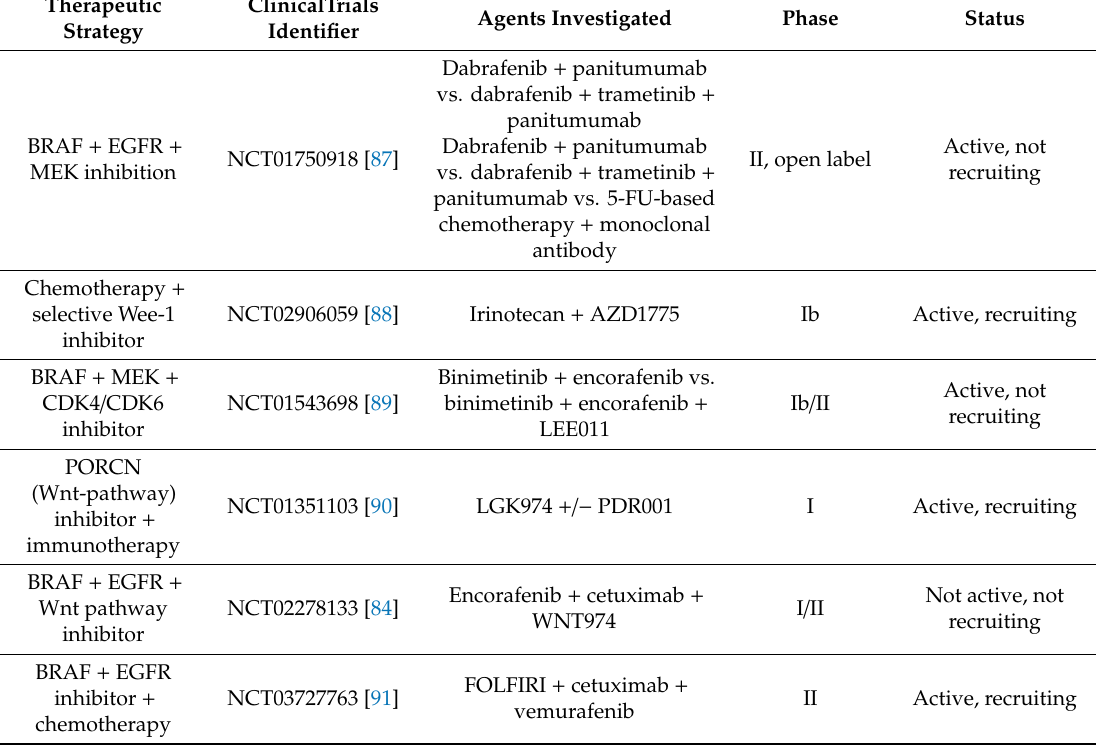
Table 2. Ongoing studies in BRAF-mutated